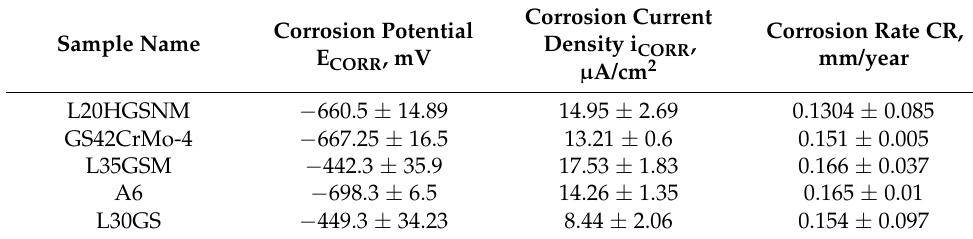
Table 4. Parameters describing the process of electrochemical corrosion of the tested materials.